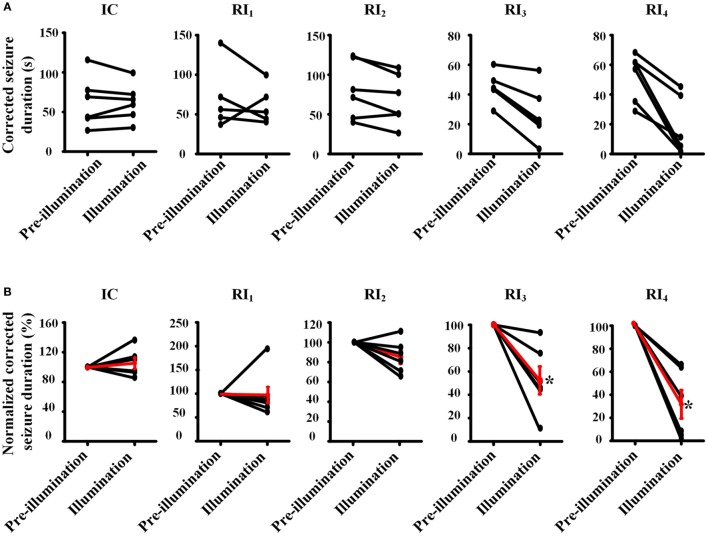
Pair-wise comparison of seizure durations between pre-illumination and illumination on 4-aminopyridine-induced seizure in rats. (A) Pair-wise comparisons of the duration of seizure between before and after illumination were performed for each animal (absolute time). (B) Normalized pair-wise comparisons of the duration of seizures between before and after illumination. The black line shows the comparison result for each animal, and the red line shows mean results for each group. Both results showed that the seizure durations are significantly decreased in the groups of RI3 and RI4.